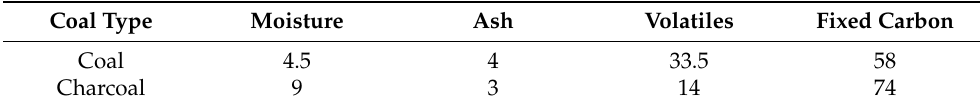
Table 2. Proximate analysis of coal and charcoal (wt %).